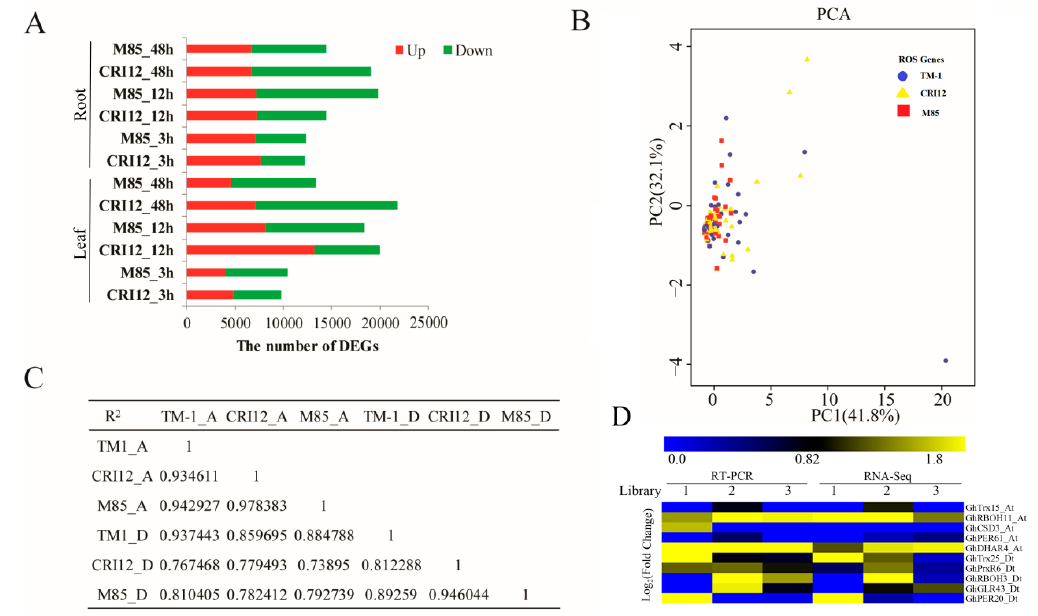
Figure 7. RNA-Seq analyses and RT-qPCR validation of the ROS network genes in M85 and CRI12 under alkali-salt stress. ( A ) The number of differentially expressed genes (DEGs) of G. hirsutum races marie-galant (M85) and G. hirsutum cultivar (CRI12) under complex alkali-saline stress at 3, 12, and 48 h. Red block is up-regulated DEGs. Green block is down-regulated DEGs. ( B ) PCA (principal component analysis) plot of the first two components for genes of ROS network. The dot color scheme represents different cotton accession (TM1, red; M85, yellow; CRI12, blue.). ( C ) Correlation coefficients of TM-1, CRI12, and M85. ( D ) RT-qPCR analysis of selected ROS genes, 1, 2, and 3 refers to the libraries, yellow-upregulated, blue: down-regulated, and black: no expression.